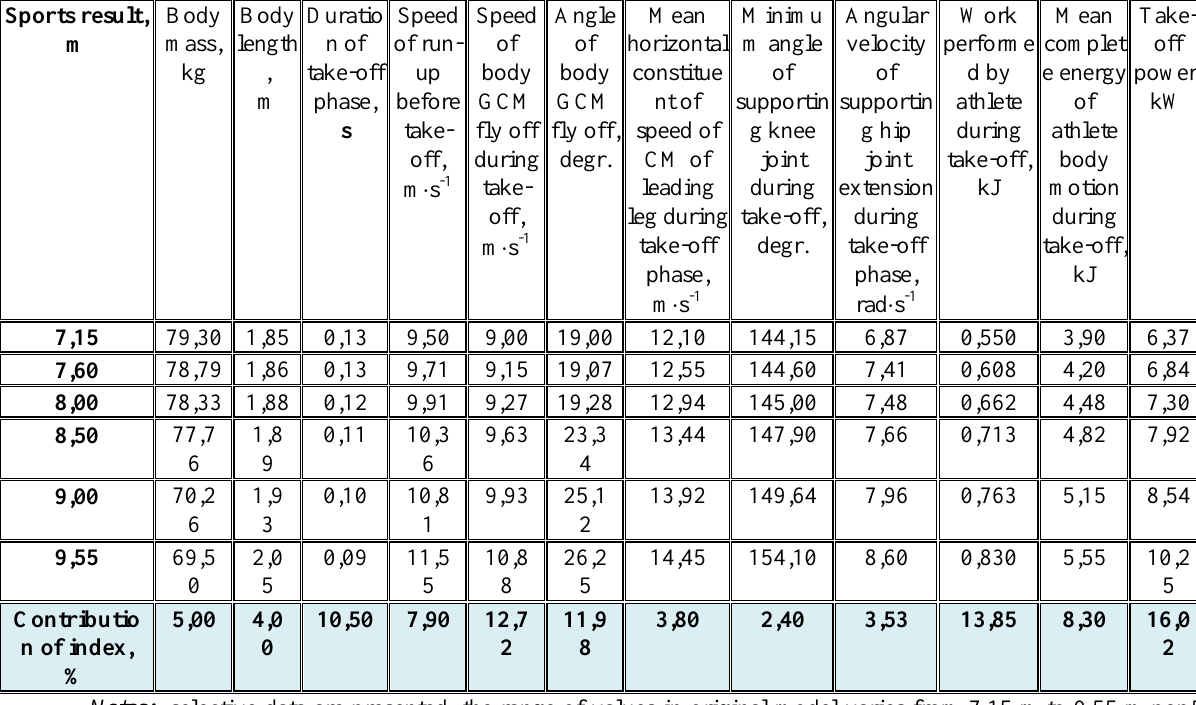
Quantitative characteristics of motor actions multifunctional biomechanical models, providing the achievement of targeted sports results in long jumps